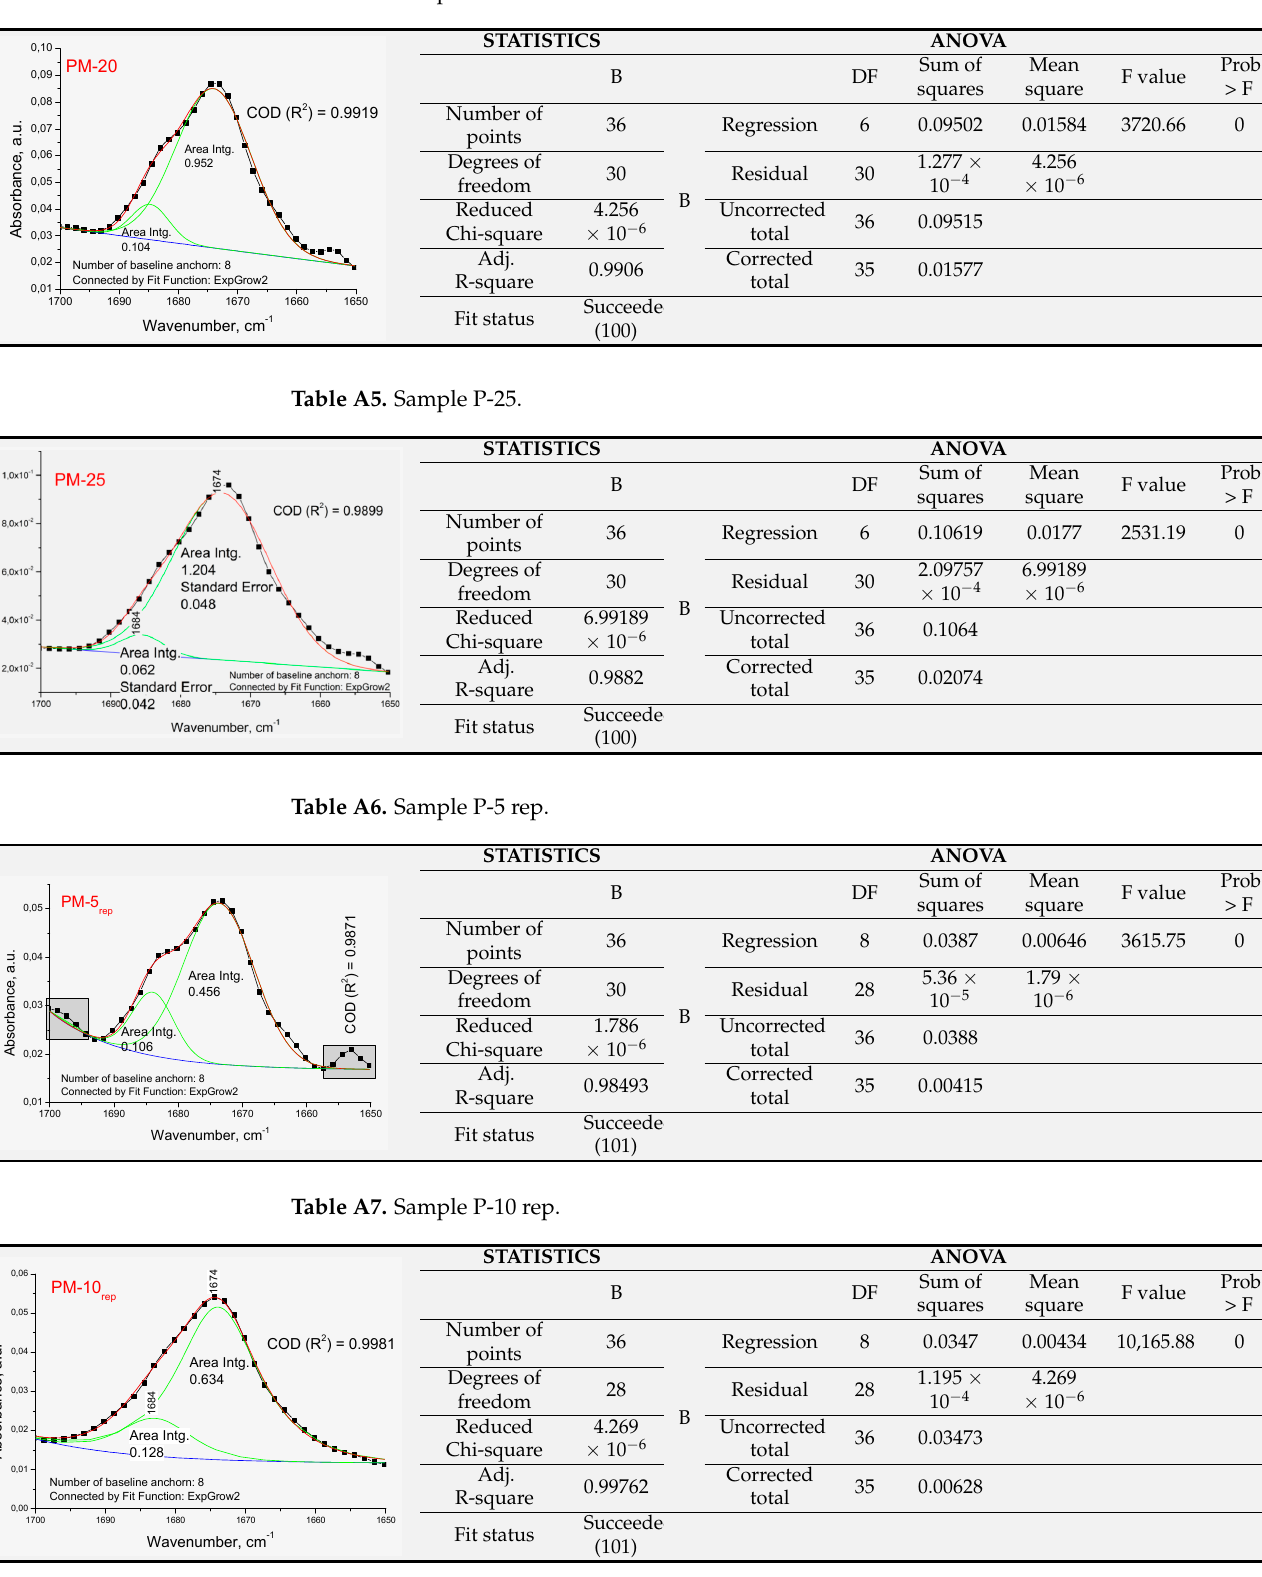
Table A8. Sample P-15 rep.